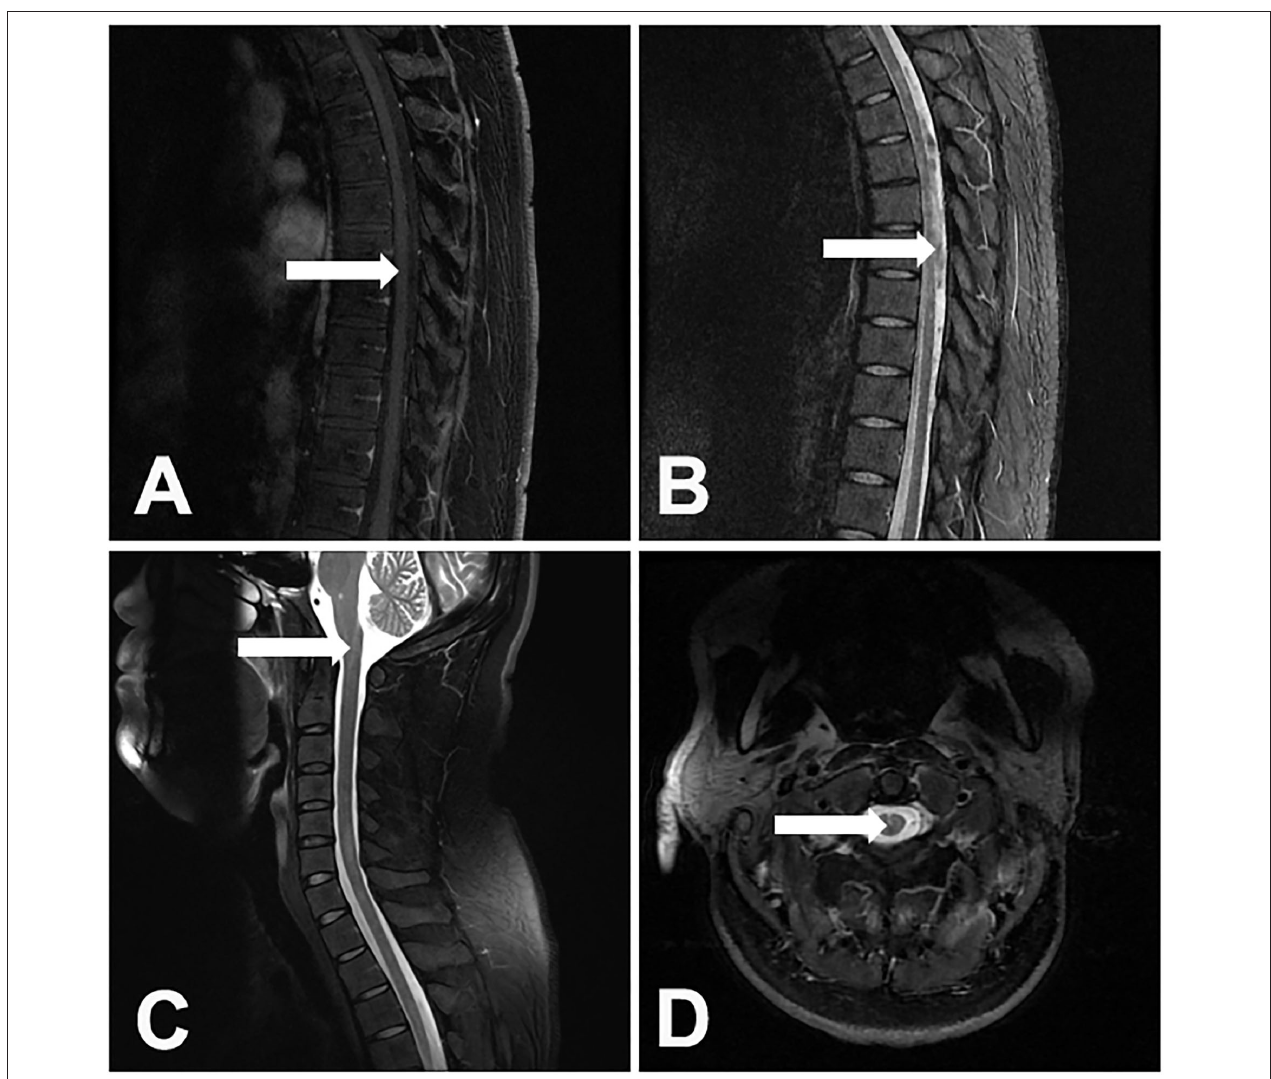
FIGURE 3 | A 31-year-old male patient developed paradoxical myelitis. The patient developed new spinal cord lesions 3 months after the start of antituberculosis treatment, when his symptoms of headache, fever, and disturbance of consciousness were gradually alleviated. A T1-weighted sagittal image of the thoracic spinal cord of the patient showed a spot-like hypointensity (A) . In the T2-weighted sequence, multiple patchy hyperintensities in the spinal cord can be seen (B) . T2-weighted sagittal and axial images of the cervical spinal cord showed an enlargement of the central canal in the spinal cord (C,D)